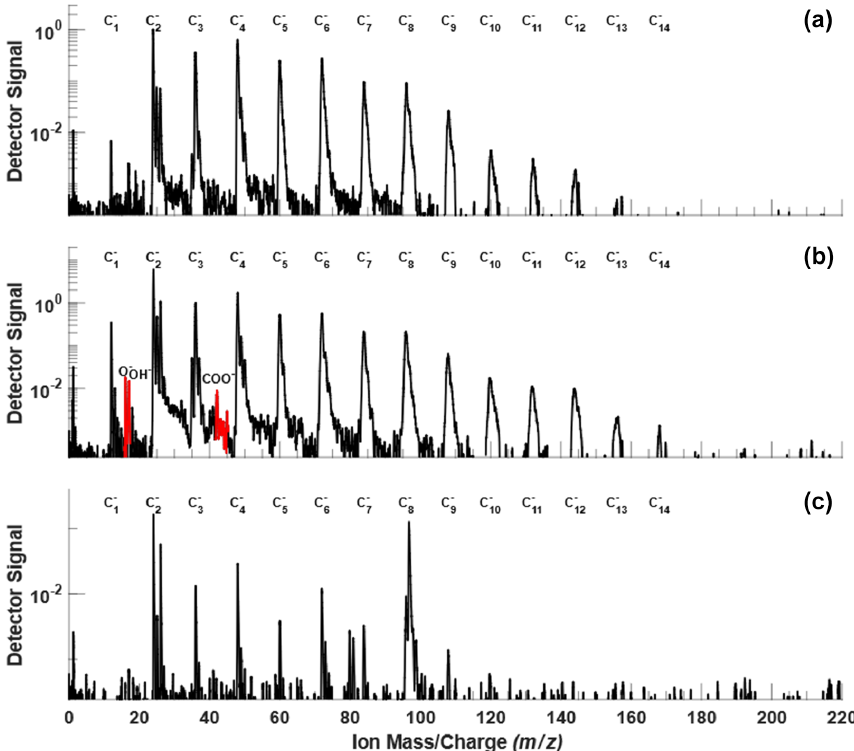
Figure A2. Representative negative ion PALMS mass spectra of bare size selected (a) R2500U, (b) COJ300, and (c) R330R BC particles, with a modal size of around 400nm. The ions indicative of oxidized material ( m/z = 16, 17, and 45) are highlighted in